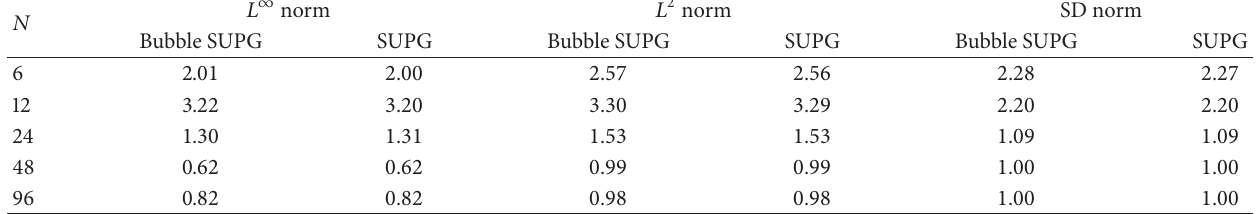
Table 5: 𝜀 = 10 −8 , Problem 2 (comparison of error).